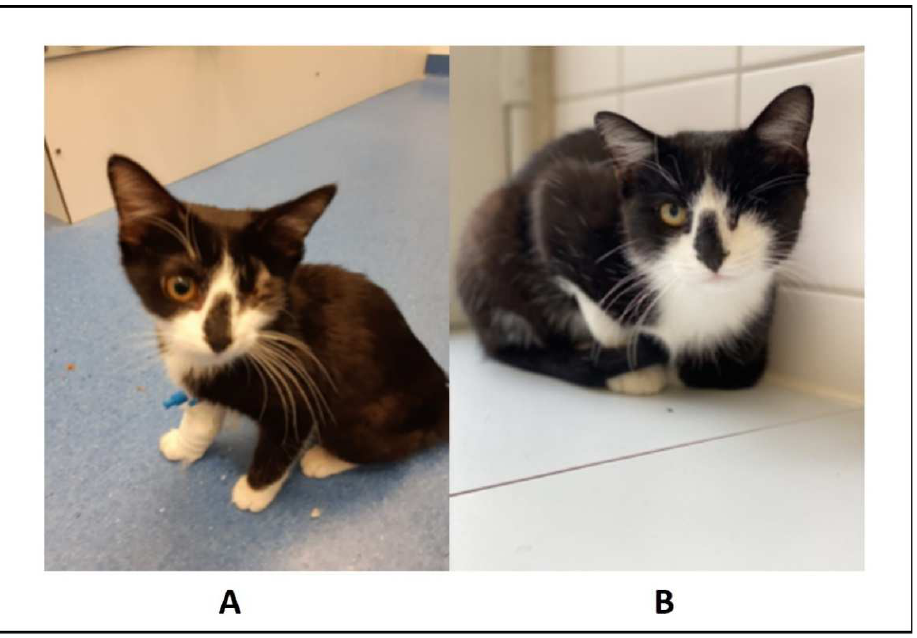
Figure 1. Pictures of the cat ( A ) on day 0 (day of first presentation in the clinic) and ( B ) on day 168, 12 weeks after the end of